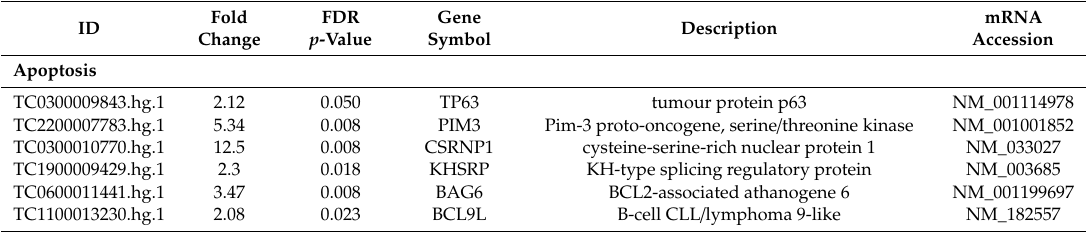
Table 1. Selected biological processes in which genes modulated in RA are